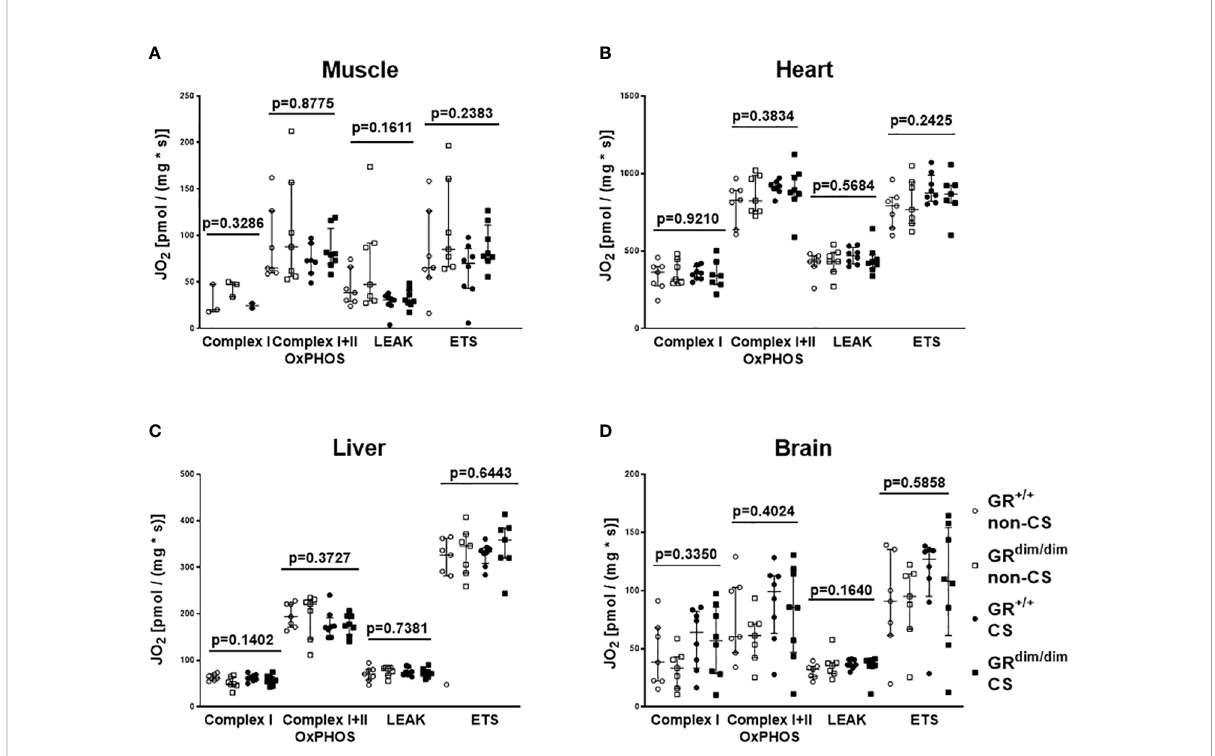
FIGURE 2 Mitochondrial respiration (JO2) in tissue from muscle (A) , heart (B) , liver (C) , and brain (D) in GR dim/dim and GR +/+ mice with or without cigarette-smoke (CS) exposure and after 1 h of hemorrhagic shock (HS, MAP 35 mmHg) and subsequent resuscitation (colloids, NE) for 4 h. Overall p-values from Kruskal-Wallis-Test are shown above. GR +/+ mice non-CS: n = 3-7, GR dim/dim mice non-CS: n = 3-7, GR +/+ mice CS: n = 2-8, GR dim/dim mice CS: n=8. For the group GR dim/dim CS in muscle tissue there were no measurements available due to a measurement problem. Data is presented as median (25 th and 75 th percentile and